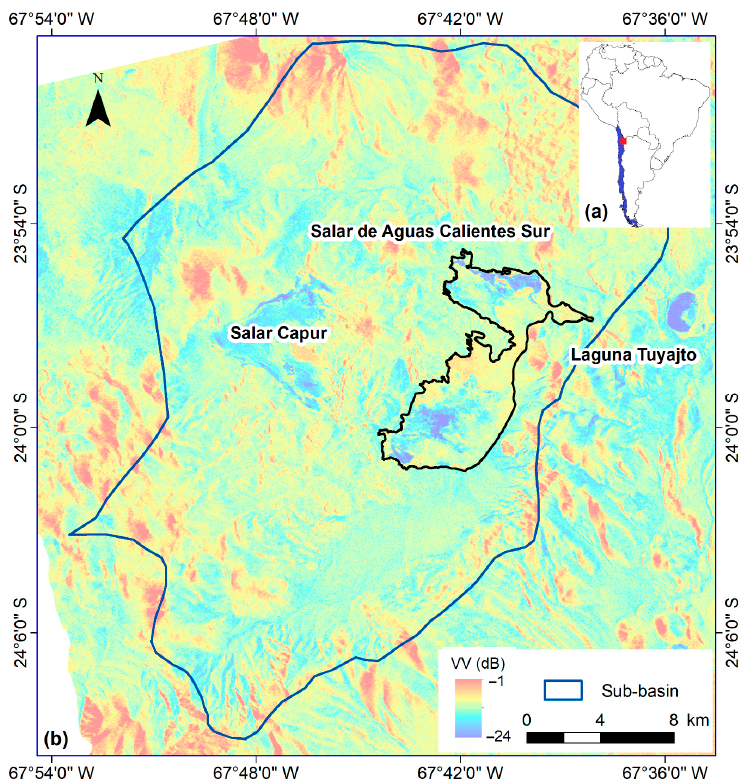
Figure 1. Study area: ( a ) Location within Chile, ( b ) Sentinel 1B image, VV polarization in decibels (dB), ascending pass, acquired on 3 April 2018, indicating the location and contour of the salar in yellow. The sub-basin has an area of 671,576 km 2 . From: http://www.geoportal.cl. (Coordinate system: GCS_WGS_1984).